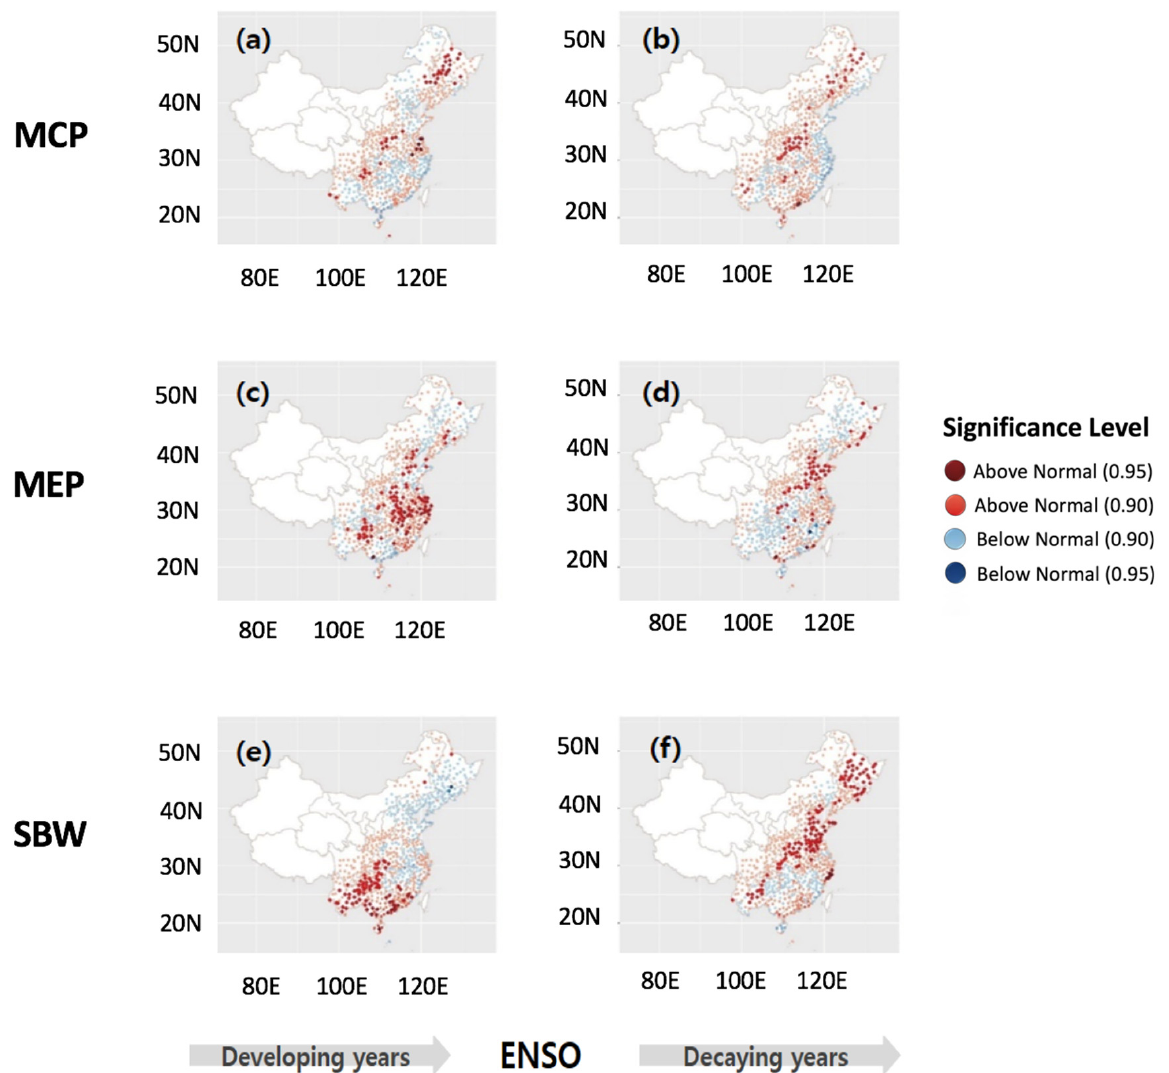
Figure 7. TC-induced composite PRCPTOT anomalies compared to the long-term averages. The red dots indicate above- normal conditions, whereas the blue dots indicate below-normal conditions. In addition, the light (dark) color groups indicate 90% (95%) significance levels for pattern changes. MCP: moderate central Pacific, MEP: moderate eastern Pacific, SBW: strong basin-wide. ( a , b ) moderate central Pacific (MCP); ( c , d ) moderate eastern Pacific (MEP); ( e , f ) strong basin- wide (SBW).